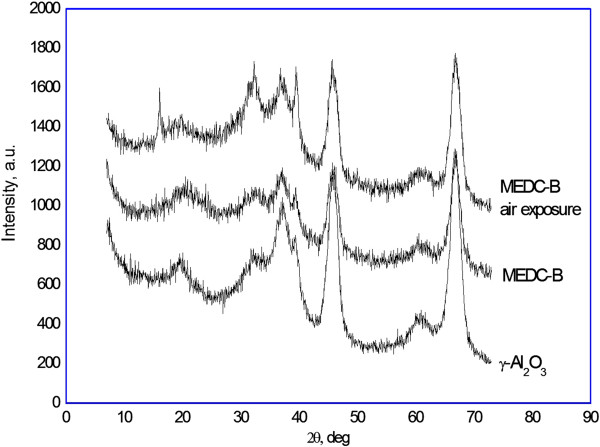
Diffraction patterns of γ-Аl2О3, MEDC-B catalysts as-received and after a few days of air exposure.